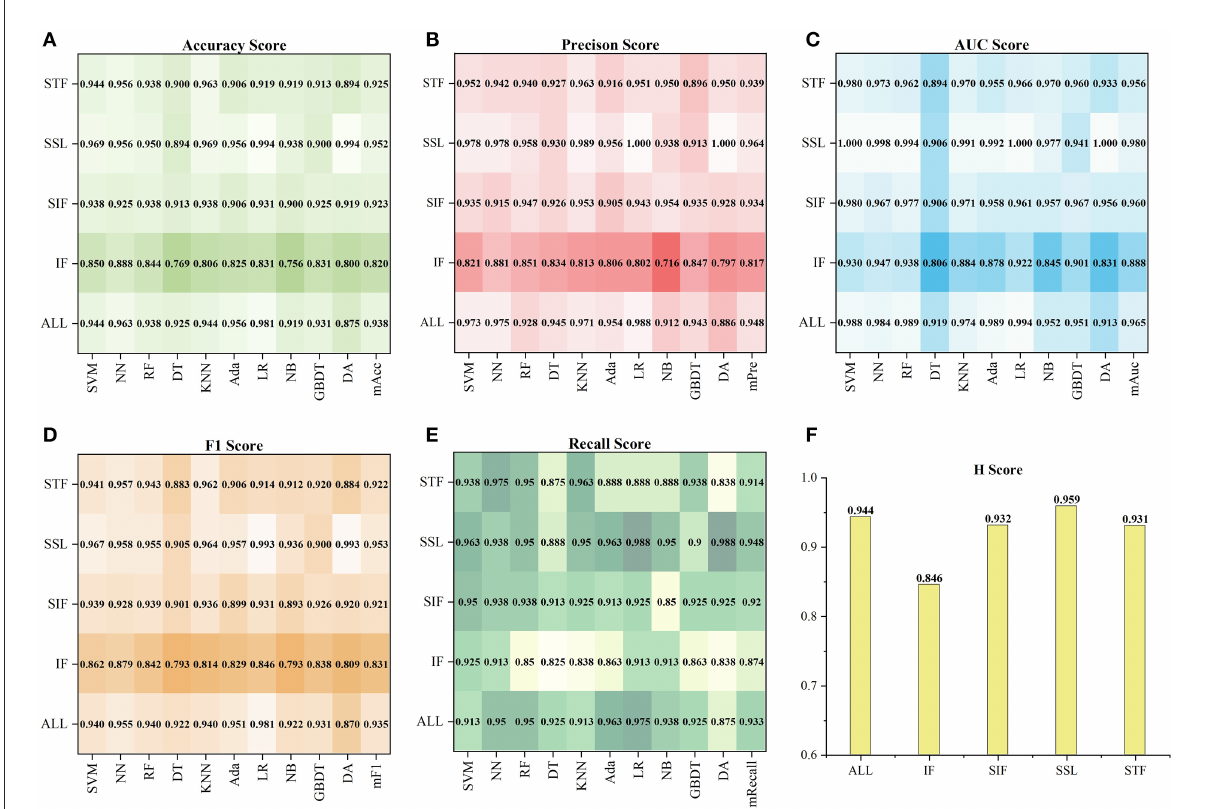
FIGURE3 The performance of each F type and F all on the ten models. (A–E) Show the five indexes (Acc, Pre, Auc, F1, Recall) of F type and F all , and (F) show the coefficients H type of